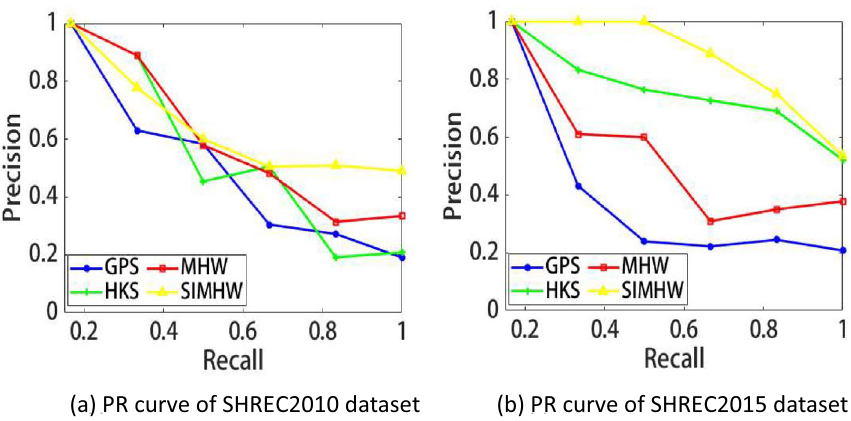
Figure 8. PR curve of the GPS, HKS, MHW and SIMHW